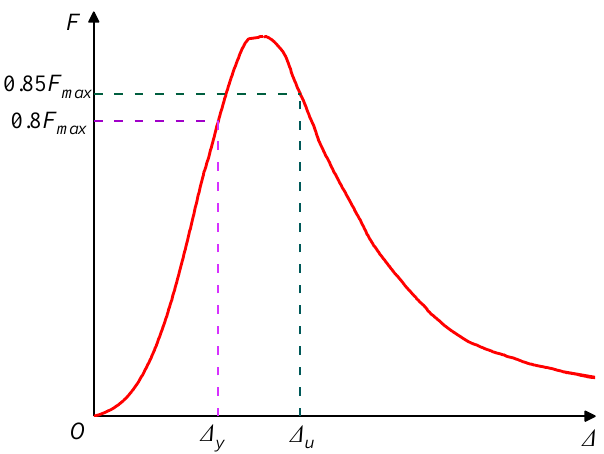
Figure 10. Schematic diagram of the calculated ductility coefficient.